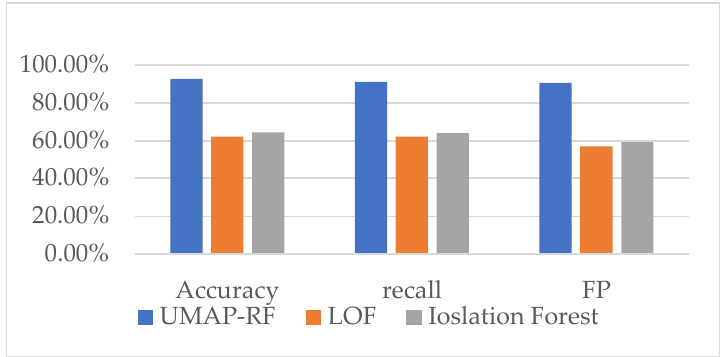
Figure 4. Histogram comparing the results of the binary classification experiment.